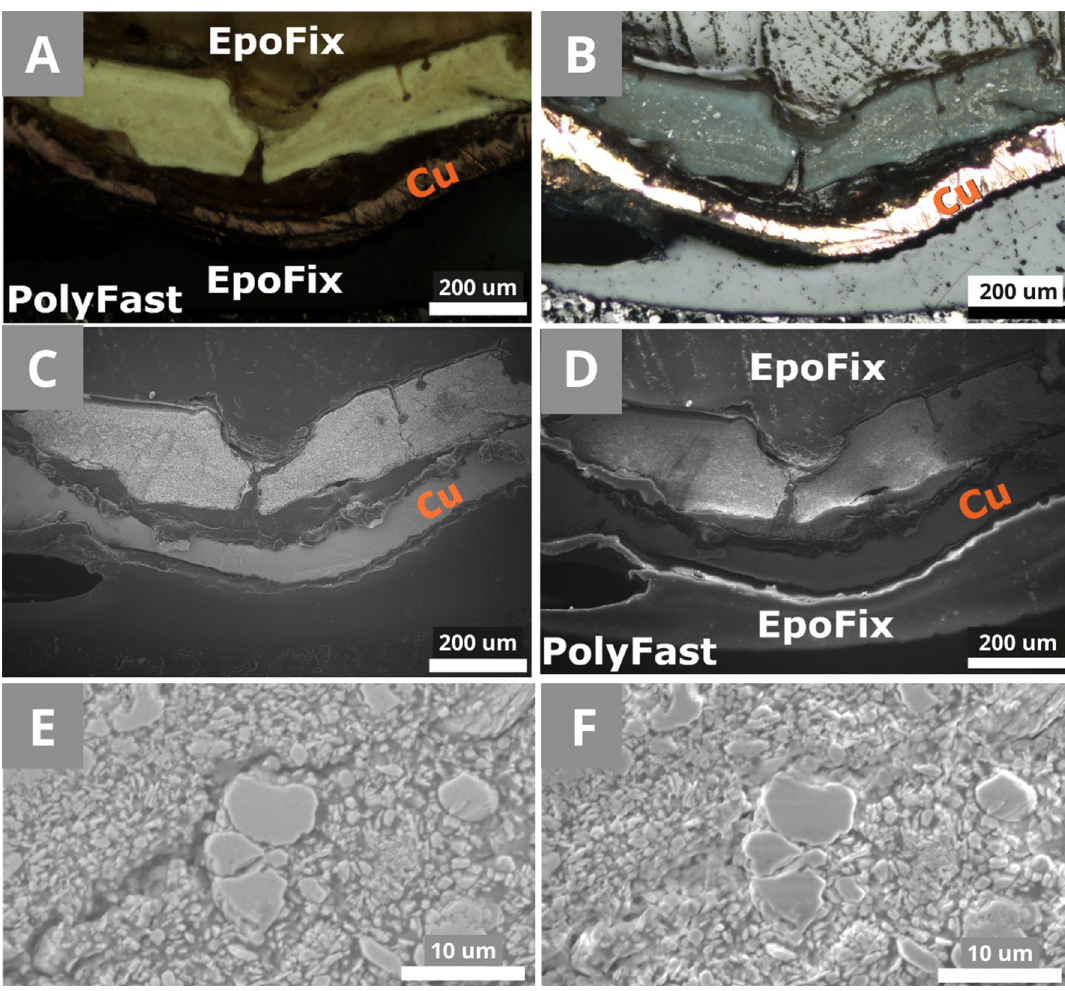
Figure 9. RS1 in preparation A. (A) Bright light and (B) polarized light microscopic image. (C) SEM-SE image at 10 kV | 50 Pa and (D) at 10 kV | 20 Pa. (E) SEM-SE image at 10 kV | 50 Pa and (F) at 10 kV | 20 Pa at a higher